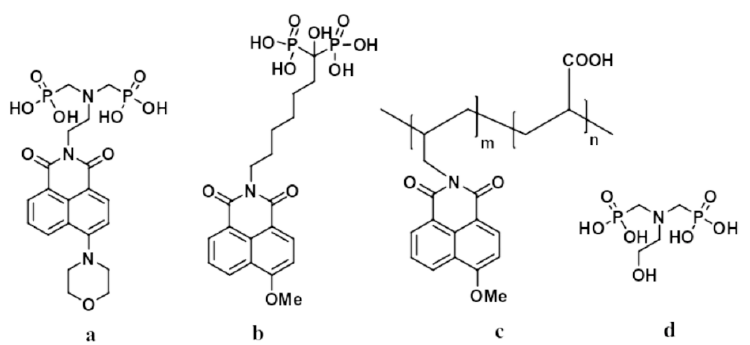
Figure 1. Chemical structures of ADMP-F ( a ), HEDP-F ( b ), PAA-F1 ( c ) and HEMPA ( d